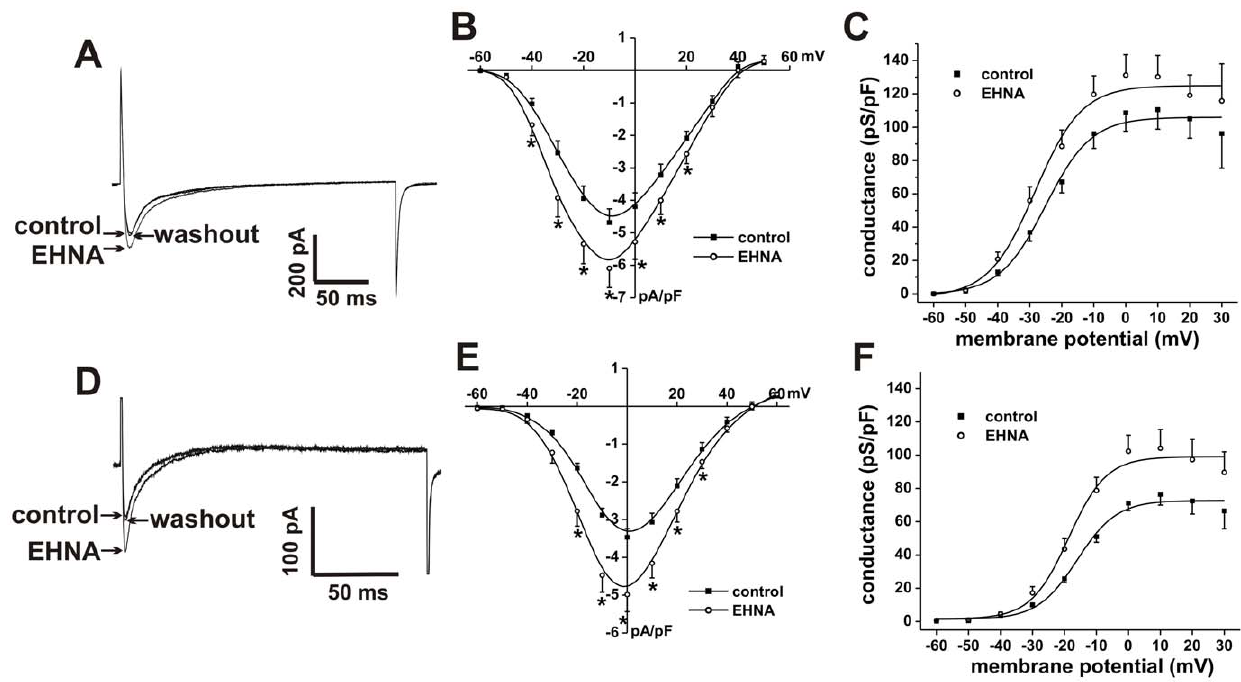
Figure 7. Effects of the PDE2 inhibitor EHNA on L-type Ca 2 + current in SAN and right atrial myocytes. A. Representative I Ca,L recordings in SAN myocytes in control conditions, in the presence of EHNA (10 m M) and following EHNA washout. B. Summary I–V relationships for the effects of EHNA on SAN myocyte I Ca,L . C. Summary I Ca,L conductance density plots for the effects of EHNA in SAN myocytes. D. Representative I Ca,L recordings in right atrial myocytes in control conditions, in the presence of EHNA (10 m M), and following EHNA washout. E. Summary I–V relationships for the effects of EHNA on right atrial myocyte I Ca,L . F. Summary I Ca,L conductance density plots for the effects of EHNA in right atrial myocytes. Summary data are means 6 SEM; n =6 SAN myocytes and 10 right atrial myocytes; * P , 0.05 vs. control by paired Student’s t -test.